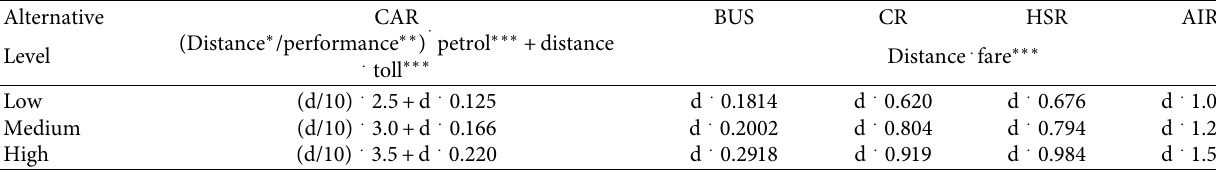
Table 2: Formulation to estimate the levels of costs per alternative.